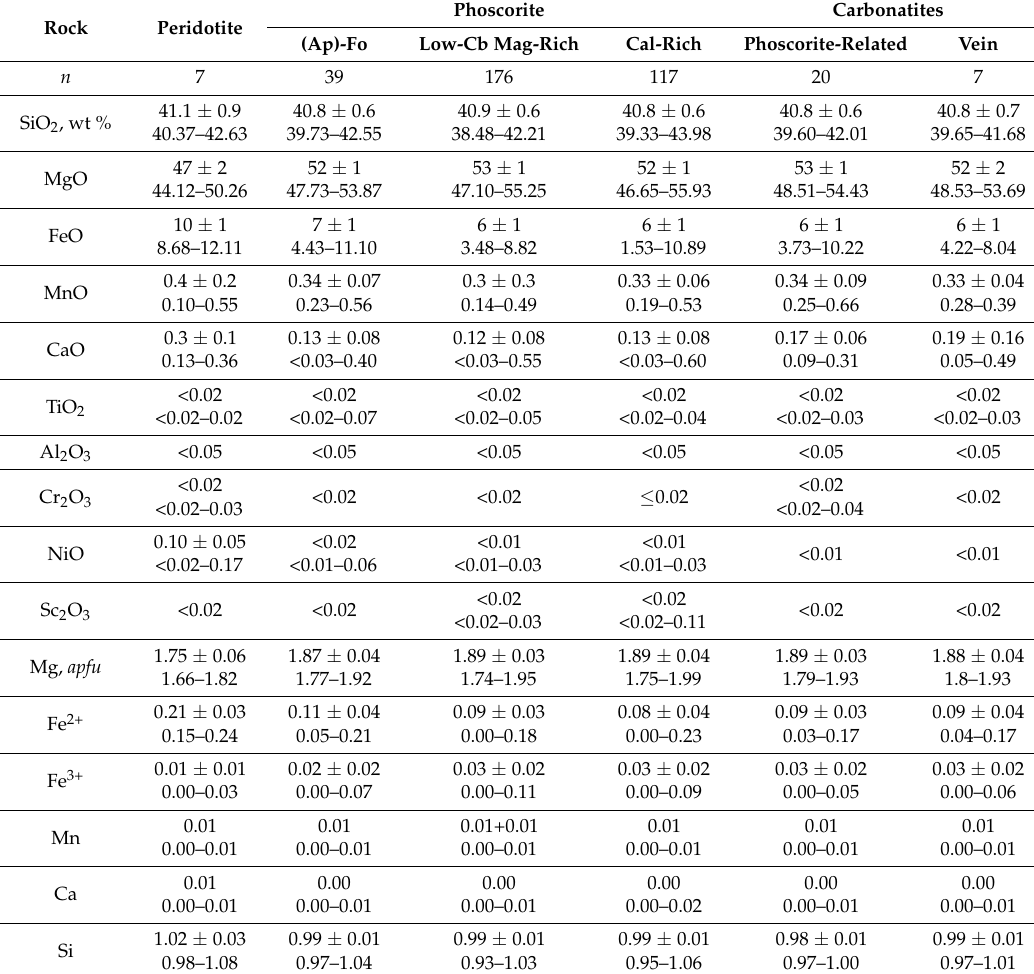
Table 3. Chemical composition of forsterite (average ±